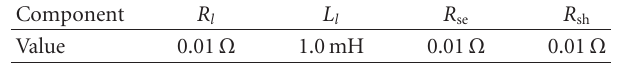
Table 2: Line impedance and VSI impedances of the UPQC.